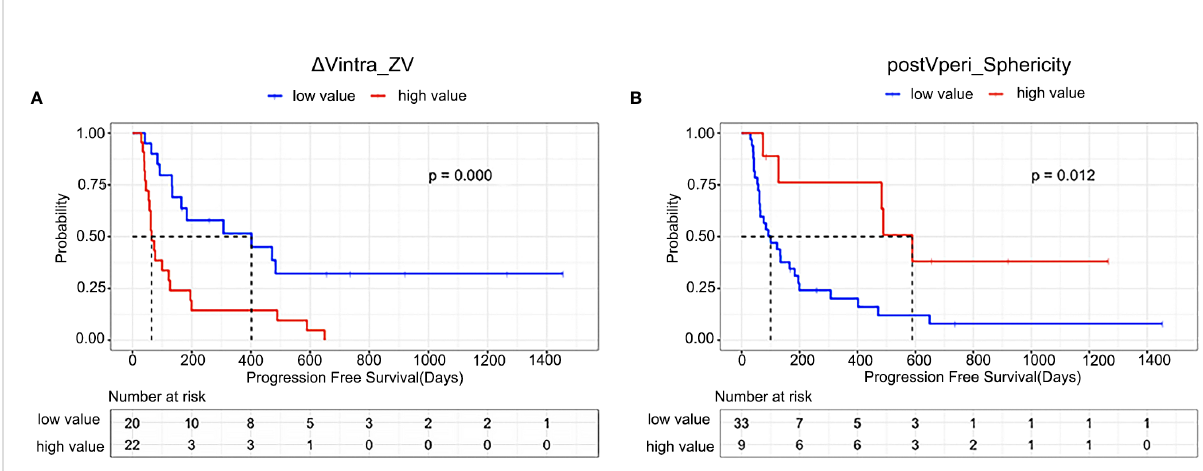
FIGURE 3 Kaplan – Meier estimates of progression-free survival in all patients according to (A) D Vintra_ZV ( D Vintra_original_glszm_Zone Variance); (B) postVperi _Sphericity